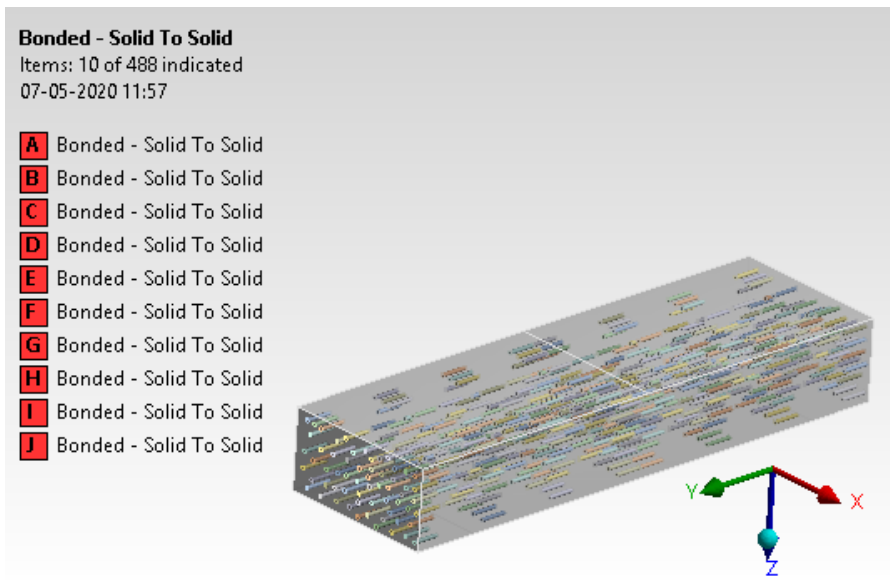
Figure 11. Contact generation.